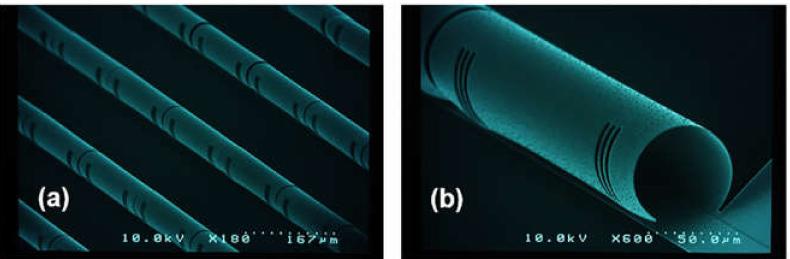
Figure 3. SEM photos of the fabricated structures of the MEMS-based micromirrors: ( a ) array; ( b )